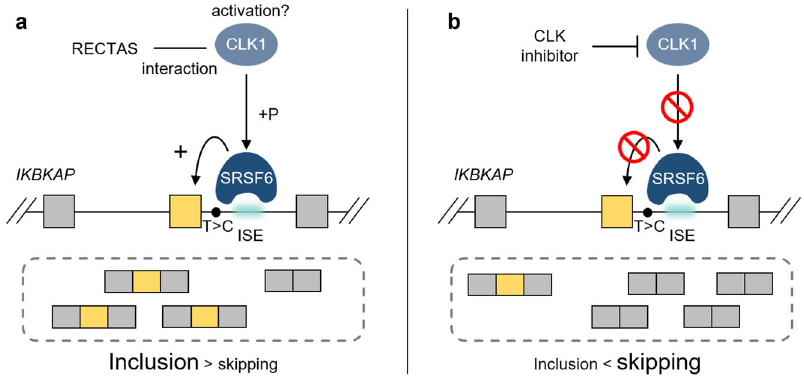
Fig. 5 Diagram for bidirectional control of IKBKAP -FD exon 20 by small molecules. a SRSF6 binding at the ISE is a major factor in the therapeutic splicing environment induced by RECTAS treatment. The requirement of CLK1 for this process and the direct interaction between CLK1 and RECTAS implies a steric effect for the activation of cellular CLK1. b For its dependence on CLK1 and SRSF6 for recognition, IKBKAP- FD exon 20 splicing can be controlled in a reverse direction by CLK inhibitor